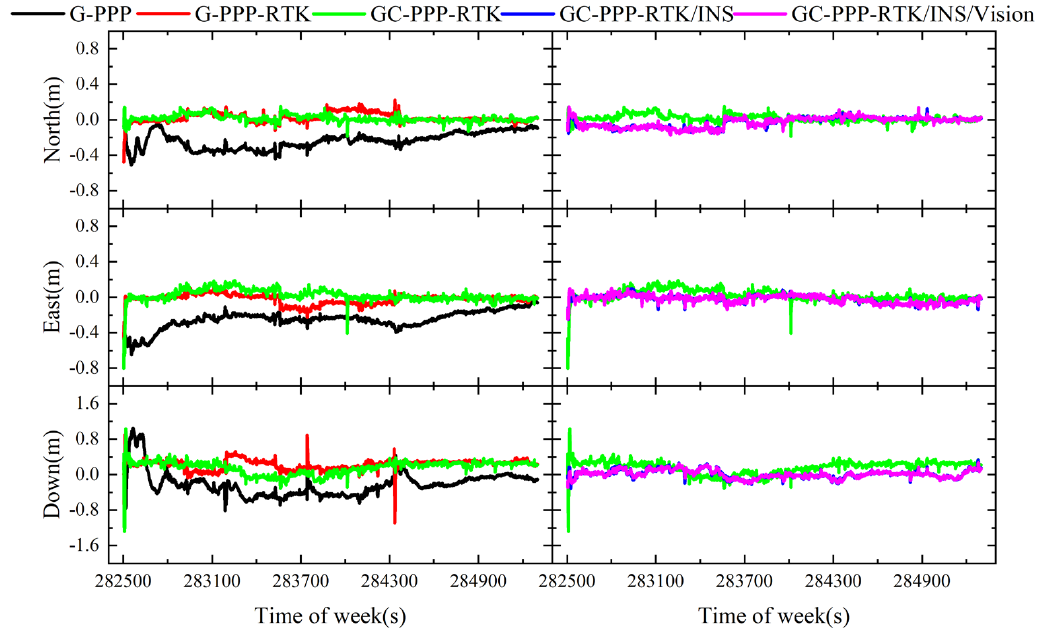
Figure 9. Position difference series of T01 in north, east, and down directions, respectively.